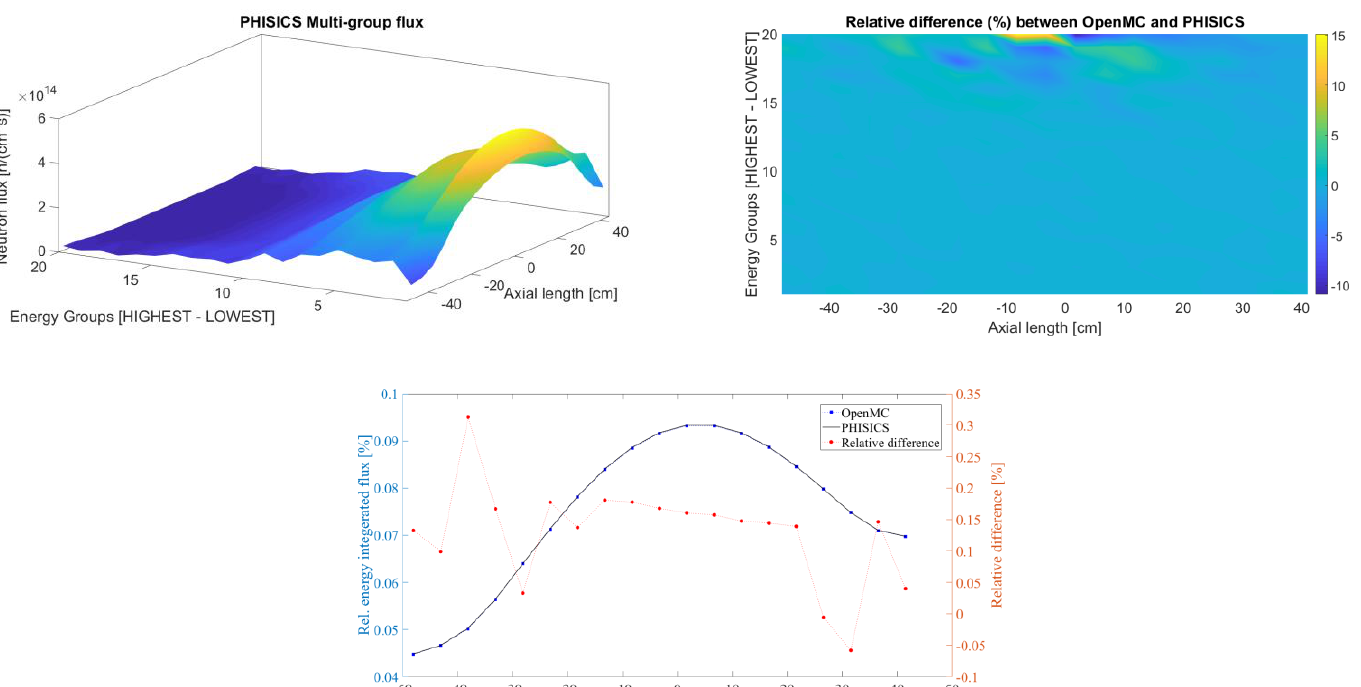
Figure 6. PHISICS vs. OpenMC MGMC benchmark for a fuel assembly located in the first